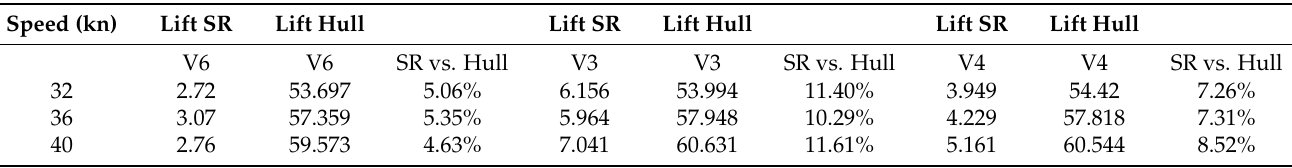
Figure 10. Variation of main computed parameters for V3, V4 and V6. Table 10. Lift computed on the hull and